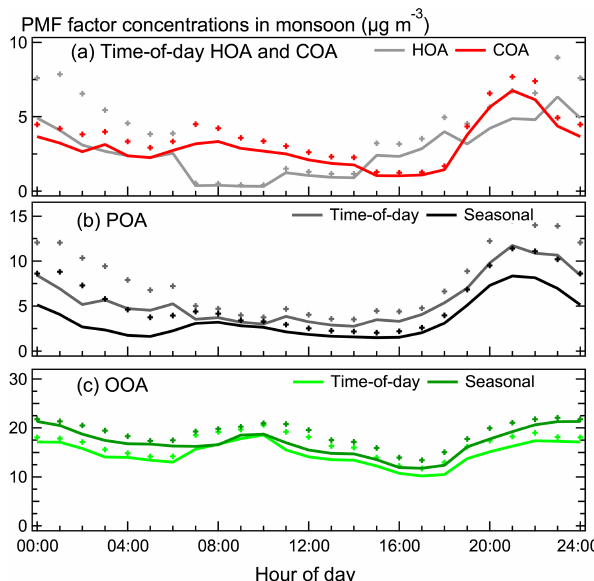
Figure 7. Seasonally representative hourly averaged diurnal mean ( + ) and median concentrations (lines) of (a) HOA and COA, (b) POA, and (c) OOA in the 2017 monsoon season from time-of- day and seasonal PMF analysis. HOA exhibits stronger episodes than COA. OOA concentrations show limited diurnal variability in both time-of-day PMF and seasonal PMF